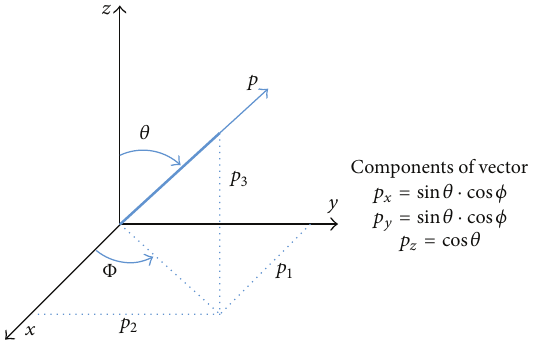
Figure 3: Description of fiber orientation by two angles [13].